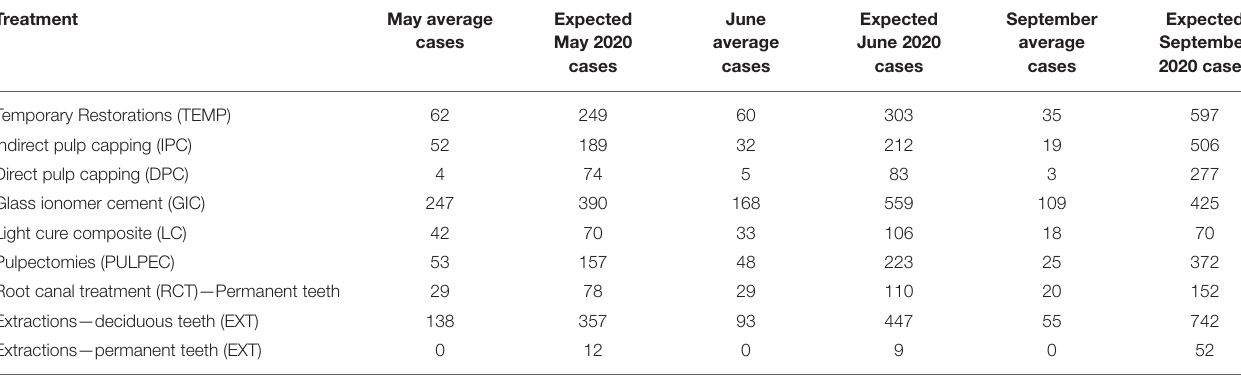
TABLE 3 | Prediction of progression of treatment needs in pediatric